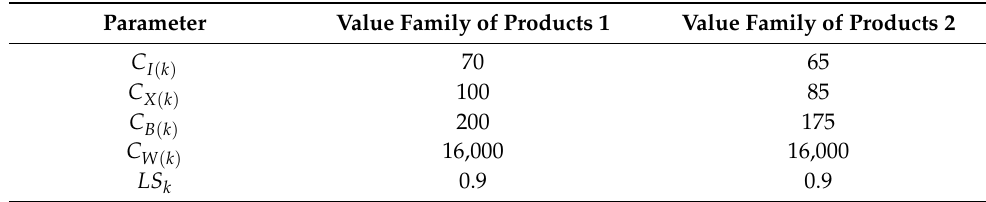
Table 3. Input data for the stochastic programming model: inventory, production, backlog, workers costs and service level.